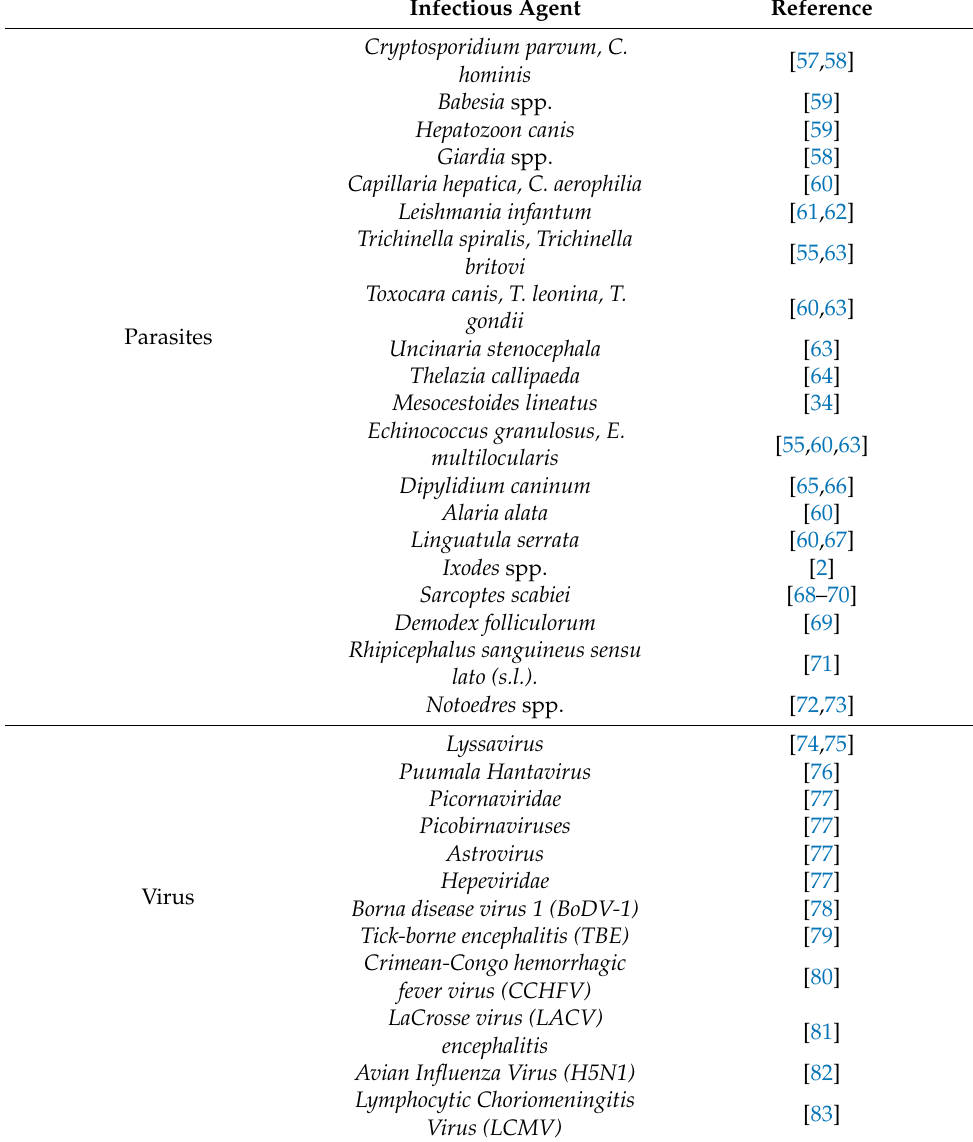
Table 2. Zoonotic agents reported in red foxes ( Vulpes vulpes